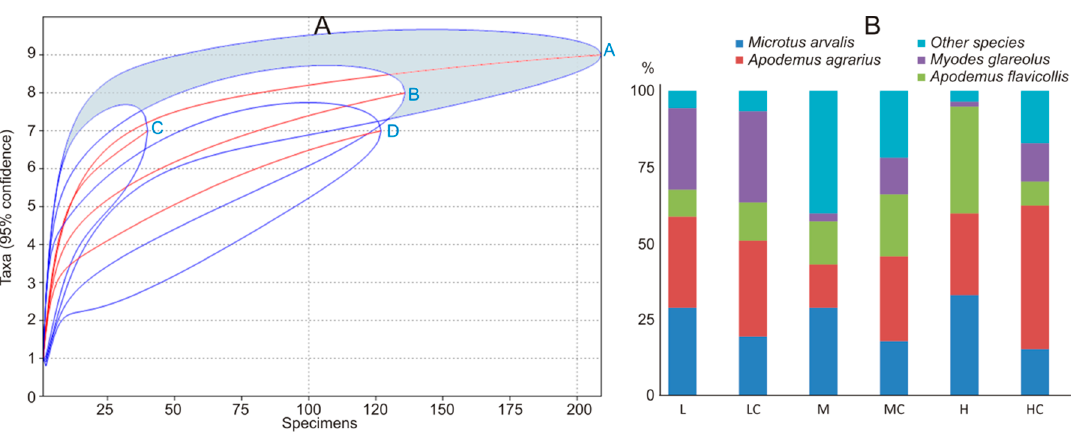
Figure 3. Small mammal species accumulation curves ( A ): A—control, B—low, C—medium, D—high intensity, and share of the dominant species in the control habitats and commercial fruit farms according to the intensity of agricultural practices ( B ): L—low intensity, LC—low-intensity controls, M—medium intensity, MC—medium-intensity controls, H—high intensity, HC—high-intensity controls.